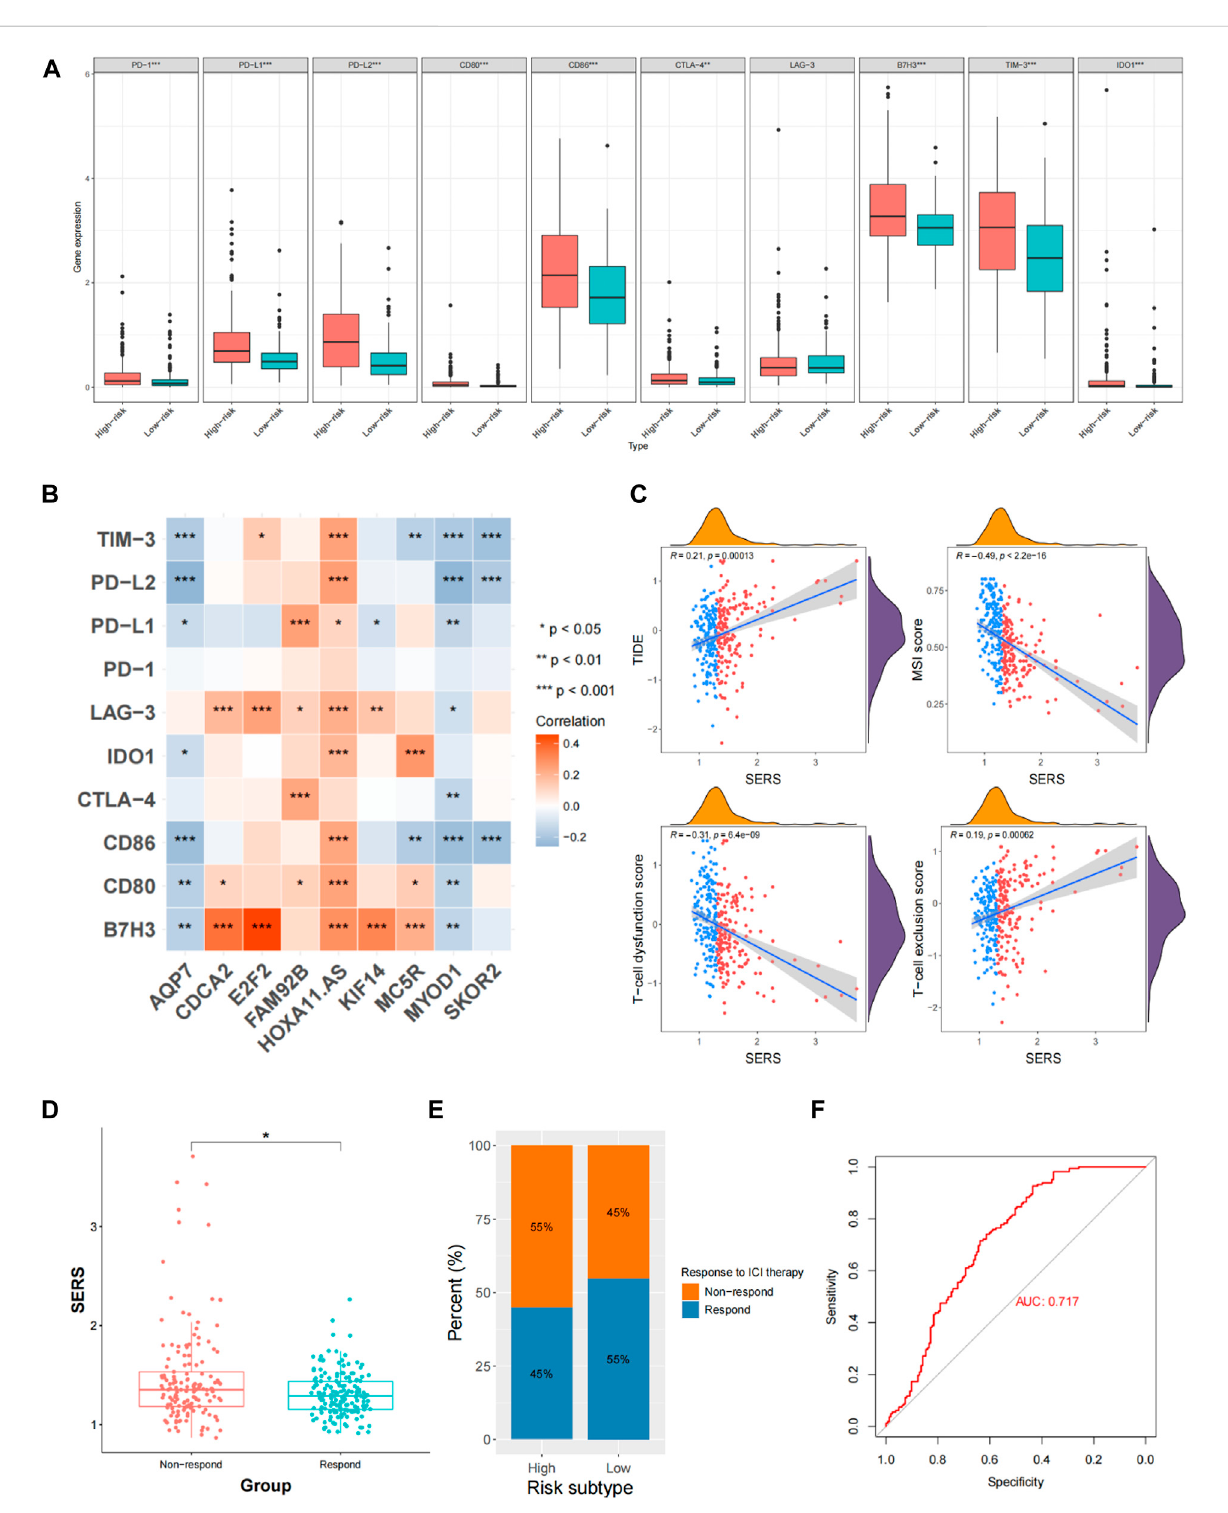
FIGURE 8 Evaluation of immune checkpoints and immunotherapy responsiveness in the TCGA cohort. (A) The expression levels of immune checkpoints and macrophage associated molecules in the high- and low-risk groups. (B) Correlation analysis between the prognosticSERS and immune checkpoints. (C) Correlation of SERS with T-cell dysfunction score, TIDE, MSI score and T-cell exclusion score. (D) The distributions of risk scores between non-respond and respond groups. (E) Comparative analysis of the response rates to ICI treatment in the high- and low-risk groups. (F) The ROC curve of predicting immunotherapeutic bene fi